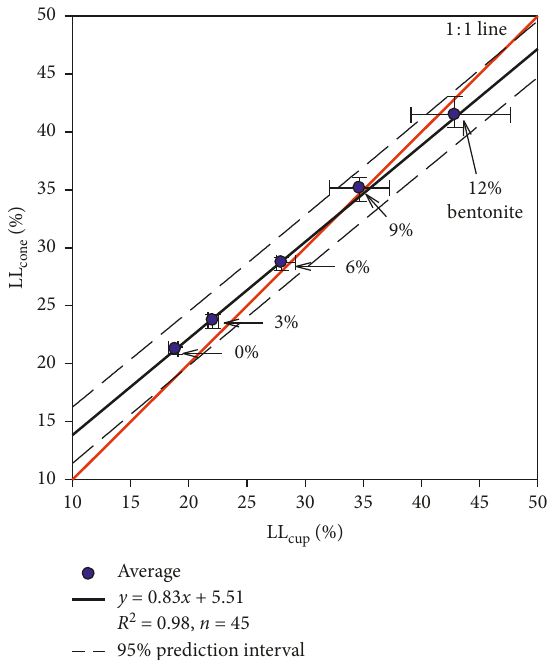
Figure 4: Correlation between LL values determined using Casagrande cup and fall cone device (3 operators × 3 replicates for each bentonite content). Note. Error bars show the maximum or minimum